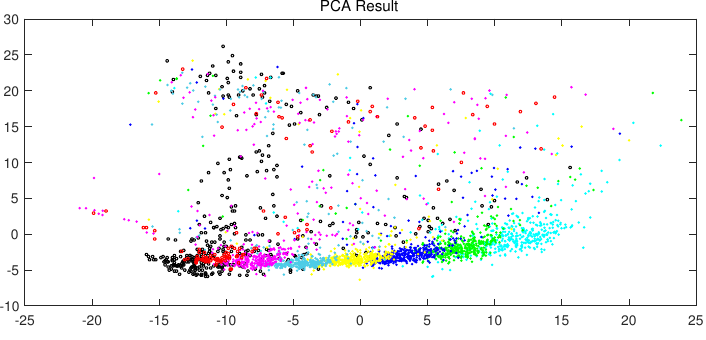
Figure 6. Result of dimension reduction by